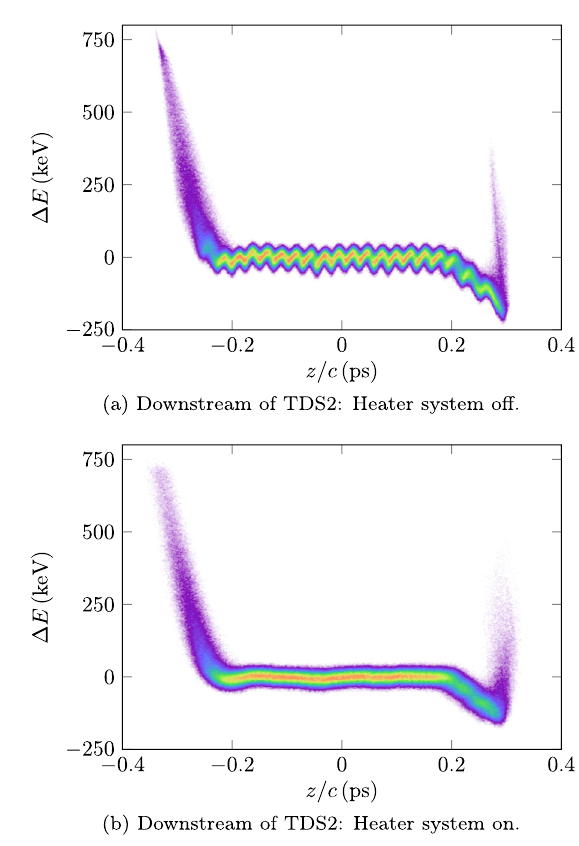
FIG. 7. Simulation on suppression of microbunching instabil- ities due to an initial density modulation, i.e., simulating CSR- driven microbunching. The entire longitudinal phase space, after removing the correlated energy chirp, is